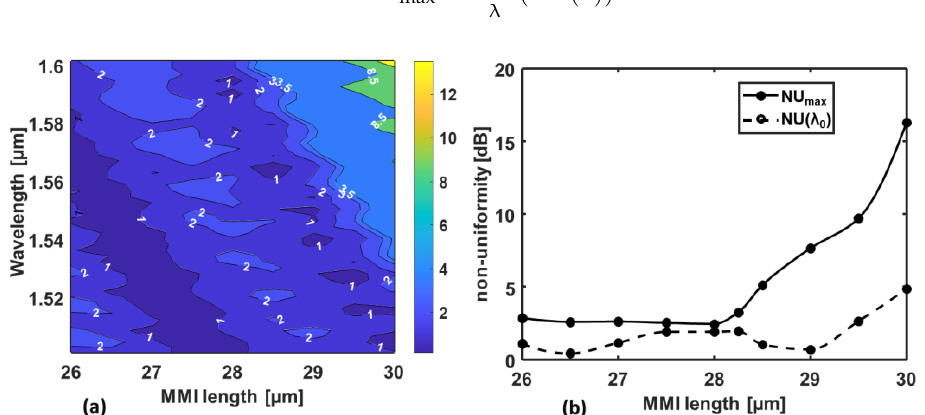
Figure 8. ( a ) Non-uniformity NU MMI at the output ports calculated in dB as a function of the MMI length and of the wavelength; ( b ) non-uniformity NU( λ 0 ) at the design wavelength λ 0 = 1.55 µ m (calculated values (dots) and polynomial fitting (dashed curve)), and maximum non-uniformity in the bandwidth NU max (calculated values (dots) and polynomial fitting (solid curve)) as a function of the MMI length. The same multilayer of the OWS is considered in the FDTD simulations with the UV26 cladding thickness t = 1 µ